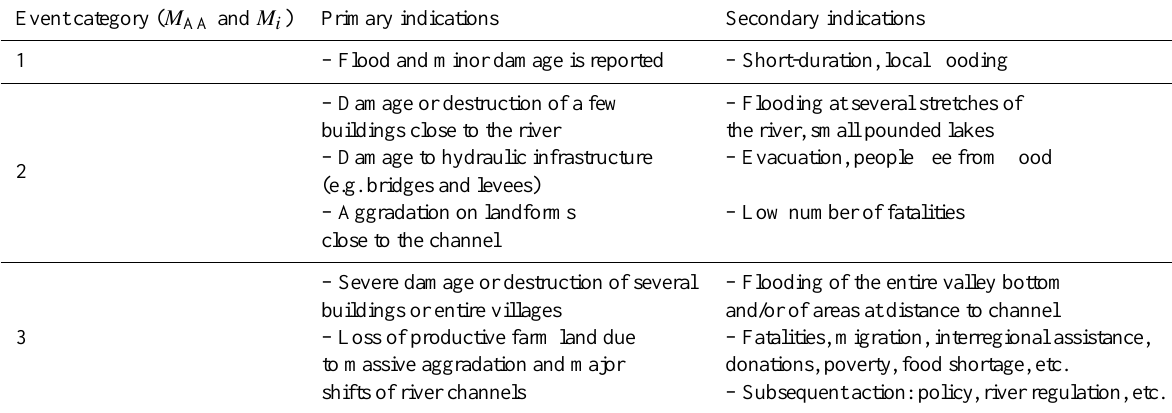
Table 1. Categories of historical Aare floods in the Hasli Valley. Event category ( M AA and M i